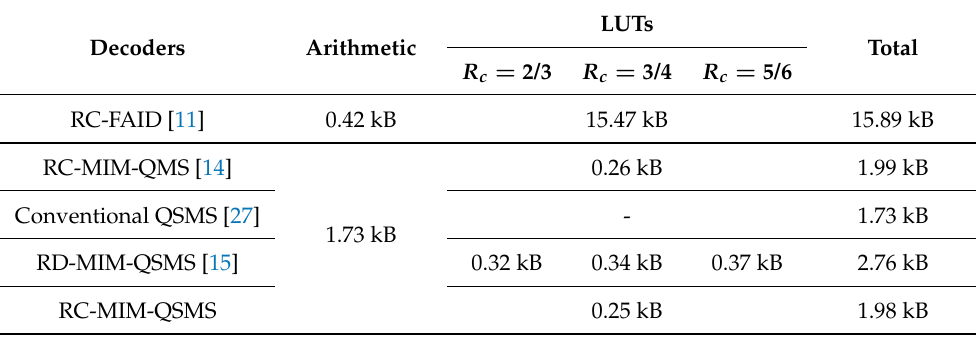
Table 5. The Overall Memory Requirement for Different Quantized Decoders with q m = 4 and T max = 15 for the 802.11n LDPC